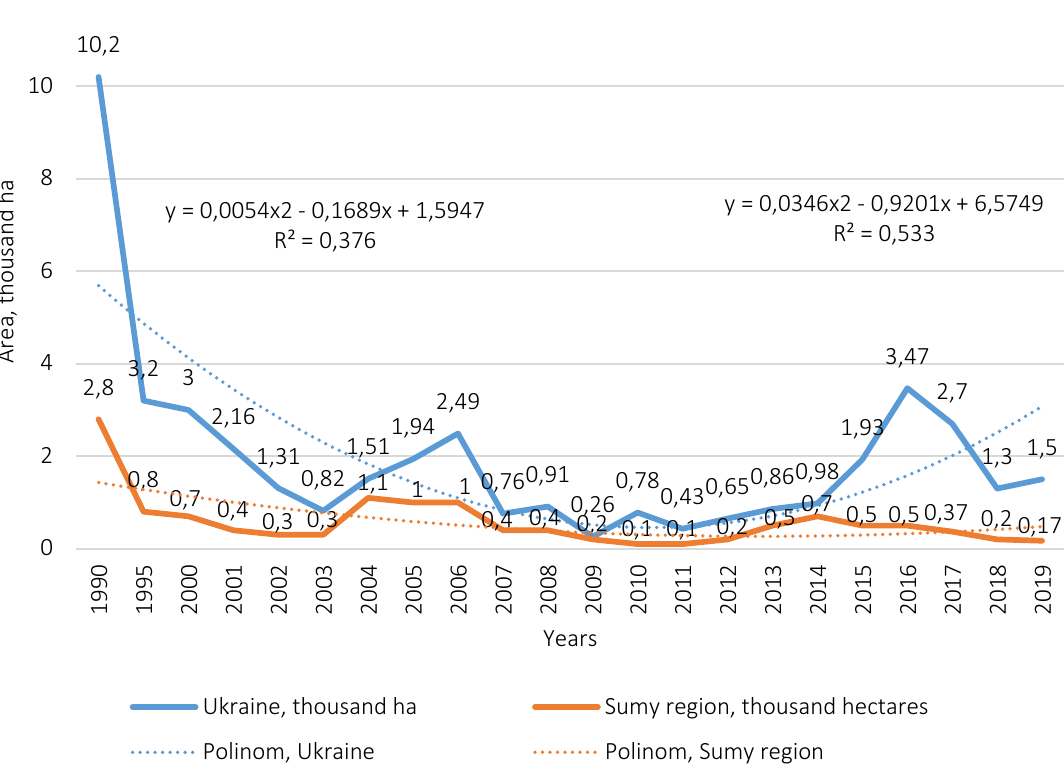
Figure 1. Dynamics of acreage of industrial hemp in Ukraine and Sumy region, thousand